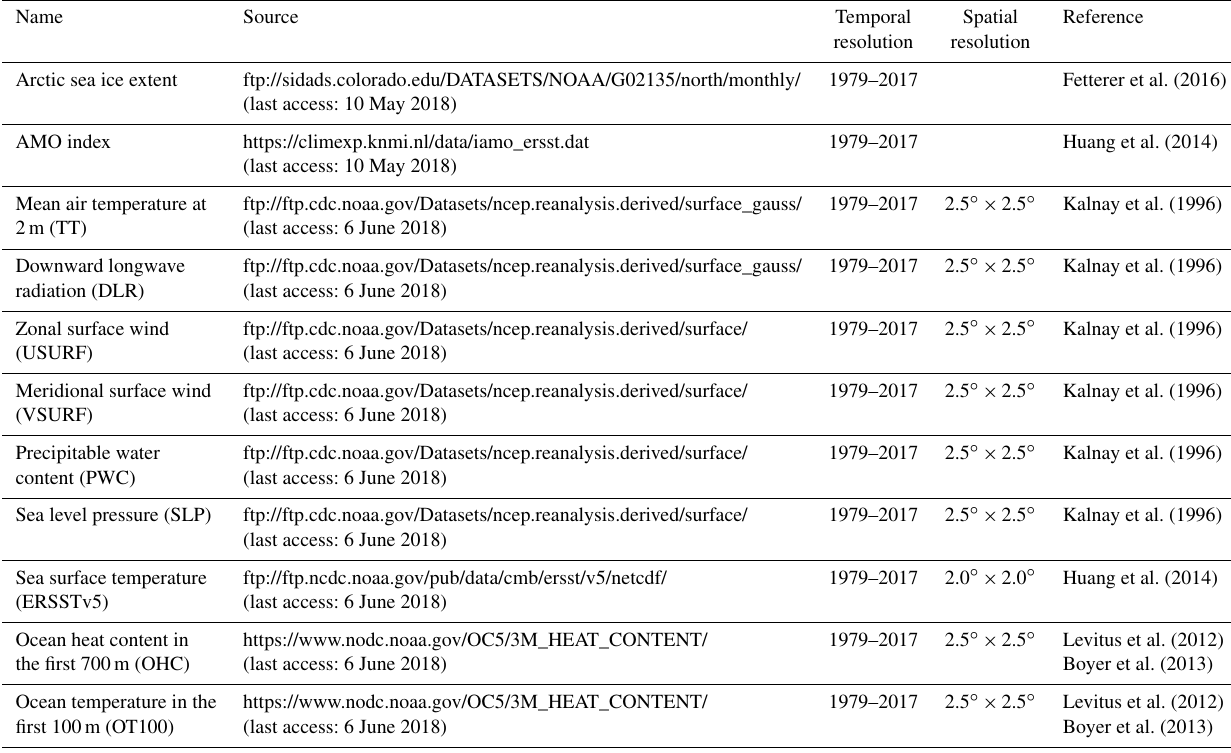
Table 1. Name, abbreviation, source, spatial and temporal resolution of the data sets used in this study. Name